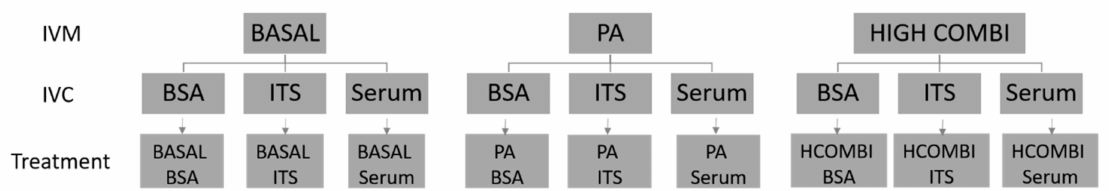
Figure 4. Overview of the nine treatment groups: BASAL-BSA, BASAL-ITS, BASAL-serum, PA-BSA, PA-ITS, PA-serum, HCOMBI-BSA, HCOMBI-ITS, HCOMBI-serum. Embryo developmental competence was assessed by recording cleavage rate (48 h p.i.) and blastocyst rate at day 7 and 8 p.i. ( n = 3737). Blastocyst quality was assessed by examining total cell count and apoptotic cell index ( n = 498). Furthermore, the metabolic profile (glucose and pyruvate consumption, lactate production; n = 389) and expression of a selected number of genes of interest (7–16 blastocysts / pool / treatment group) were also analyzed (see Figure 5). The number of replicates and COCs or blastocysts used for each outcome parameter are indicated in the results section.